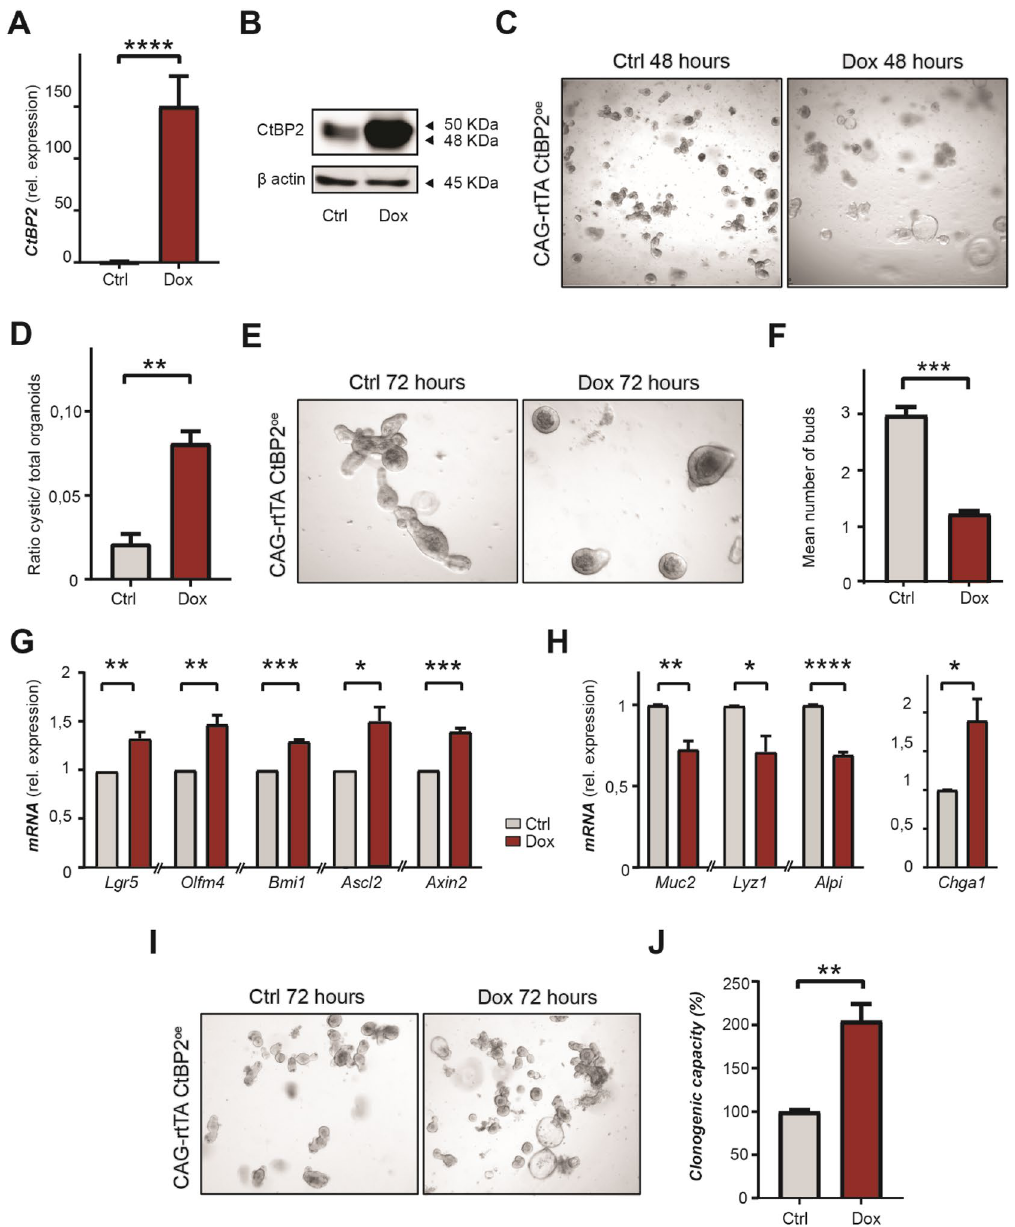
Figure 3. CtBP2 regulates stemness in mouse small intestinal epithelial organoids. ( A ) RT-qPCR of CtBP2 in wildtype or CtBP2 overexpressed mouse small intestinal organoids 48 h after doxycycline-induced CtBP2 overexpression (n = 3). ( B ) CtBP2 protein expression by western blot in CAG-rtTA- CtBP2 organoids, 48 h after treatment with doxycycline. Full-length blots/gels are presented in Supplementary Immunoblotting Data Figure 4. ( C ) Representative image of CAG-rtTA- CtBP2 mouse small intestinal organoids 48 h after doxycycline-induced overexpression. ( D ) Quantified ratio of cystic organoids to normal organoids 48 h after doxycycline-induced CtBP2 overexpression in (n = 3). ( E ) Representative images of budding in CAG- rtTA- CtBP2 mouse small intestinal organoids, 72 h upon doxycycline-induced CtBP2 overexpression. ( F ) Mean number of buds per organoid in CtBP2 wildtype (non-induced) versus doxycycline-induced CtBP2 overexpression organoids (n = 3). ( G ) RT-qPCR of stem cell markers and ( H ) differentiation markers in CAG- rtTA- CtBP2 mouse small intestinal organoids 72 h after doxycycline-induced CtBP2 overexpression (n = 3). ( I ) Representative images of outgrowth of induced CAG-rtTA- CtBP2 organoids 72 h after single cell seeding. Images were captured with a Leica DM6000 microscope using LAS AF software (Leica, Wetzlar, Germany). All western blot images were generated and exported using ImageQuant LAS 4000 software and cropped and labeled using Adobe Illustrator software version 25.2. ( J ) Calculated clonogenic capacity (%) of induced CAG-rtTA- CtBP2 organoids after single cell seeding. Graph bars show mean and s.e.m. * P < 0.05, ** P < 0.01, *** P < 0.001, **** P < 0.0001 (Student’s t